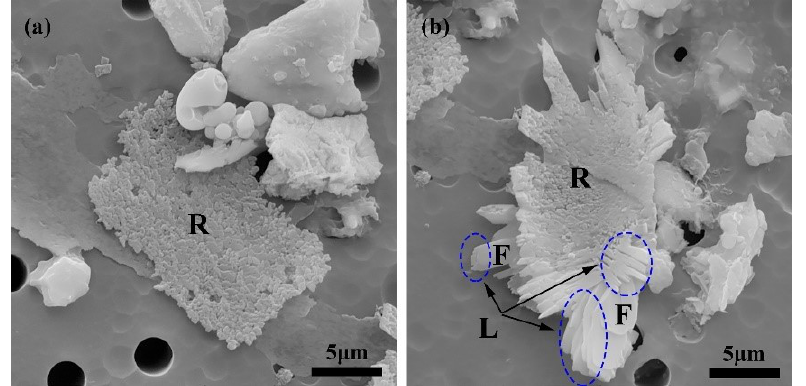
Figure 14. Rough interface CaS inclusion at S content of 0.017%. F: flat interface; R: rough interface; L: layer growth. ( a ) CaS inclusion with rough interface. ( b ) CaS inclusion with flat interface and rough interface.